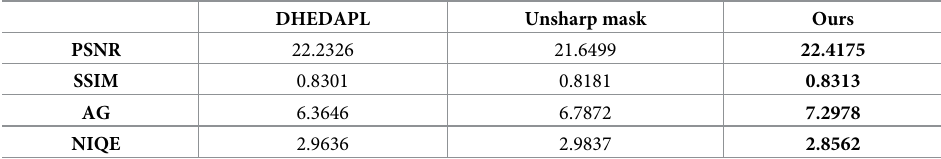
Table 2. Average value of four evaluation indexes of 20 random images of MIT-5K.